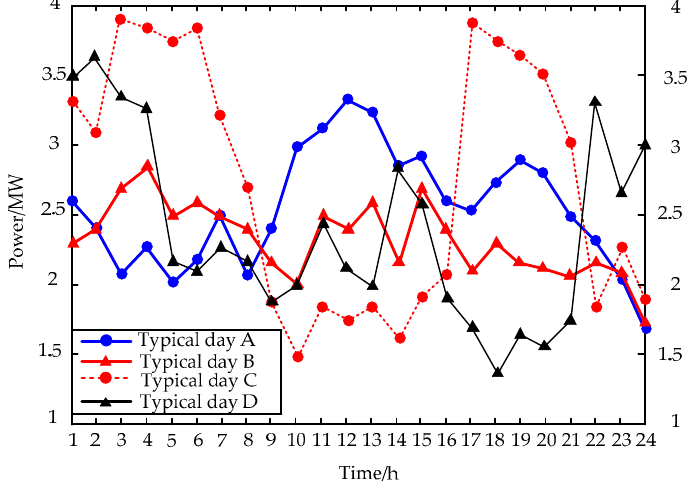
Figure 4. Typical daily power curves of A, B, C, and D obtained by wind farm prediction.